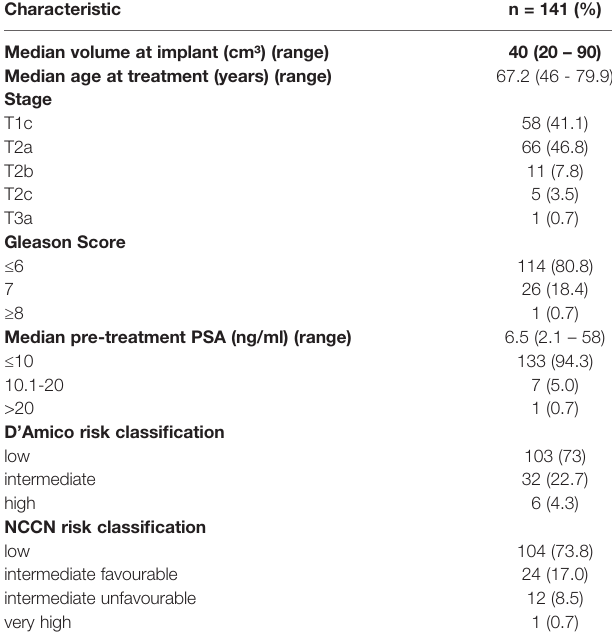
TABLE 1 | Patients and tumor